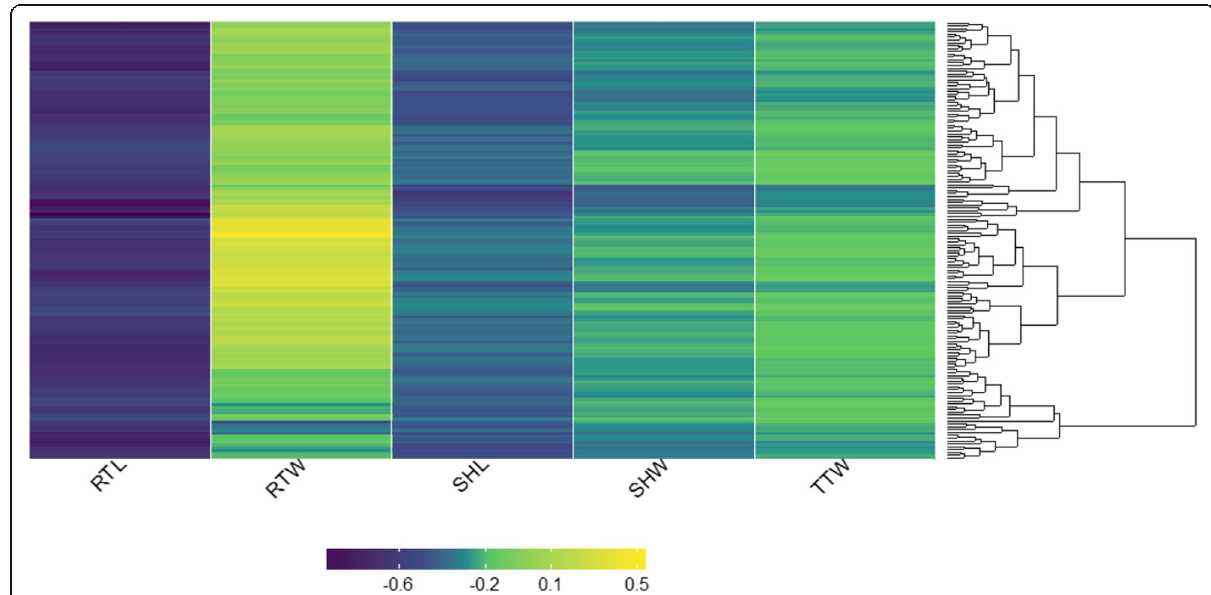
Fig. 2 Comparative visualization of genotype-phenotype relationships of 155 rice accessions. Ratio of variation or Delta value reflect for impact of JA on 5 traits including root length (RTL), root weight (RTW), shoot length (SHL), shoot weight (SHW) and total weight (TTW) respectively. The heat map was created using the “ 3dheatmap ” package in R. The negative value represent the inhibition effect of JA to the plant growth, and the positive value represent the induction effect of